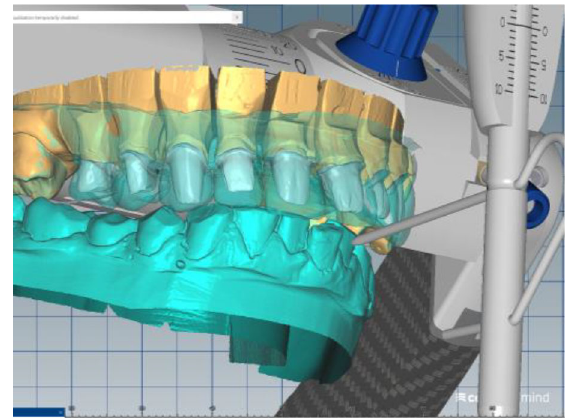
Figure 6. Digital design – increased